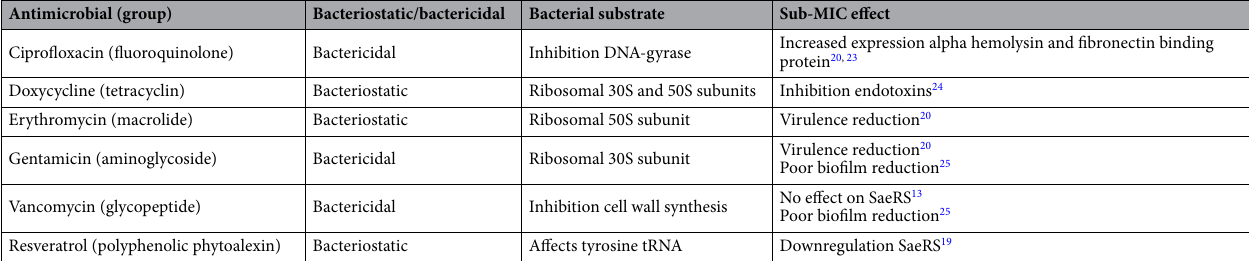
Table 1. Antimicrobials involved in this study, including working mechanism and effect on bacteria at sub- inhibitory